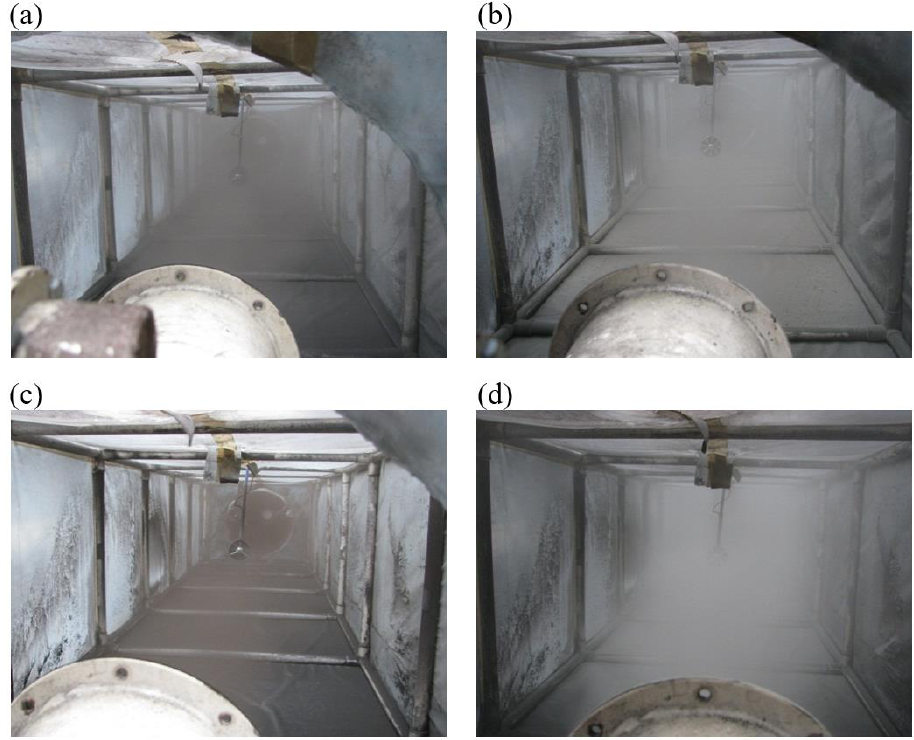
Figure 3. Dustiness in the tunnel during the tests: ( a ) stone and coal dust (50%), ( b ) stone dust (100%), ( c ) coal dust (50%), ( d ) limestone dust (100%). Measurements were made in a series of 30 samples taken with a time interval of 1 s ( “ Measurement series ” mode). The results are presented in the form of graphs, arranged in terms of the type of transducer used and the direction of ultrasonic waves propagation.